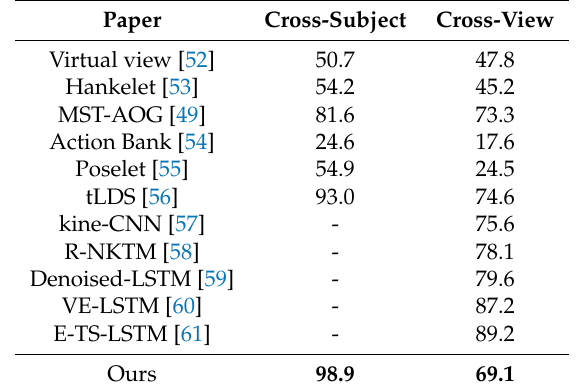
Table 5. A comparison between the proposed method and state-of-the-art approaches in terms of the NUCLA dataset.